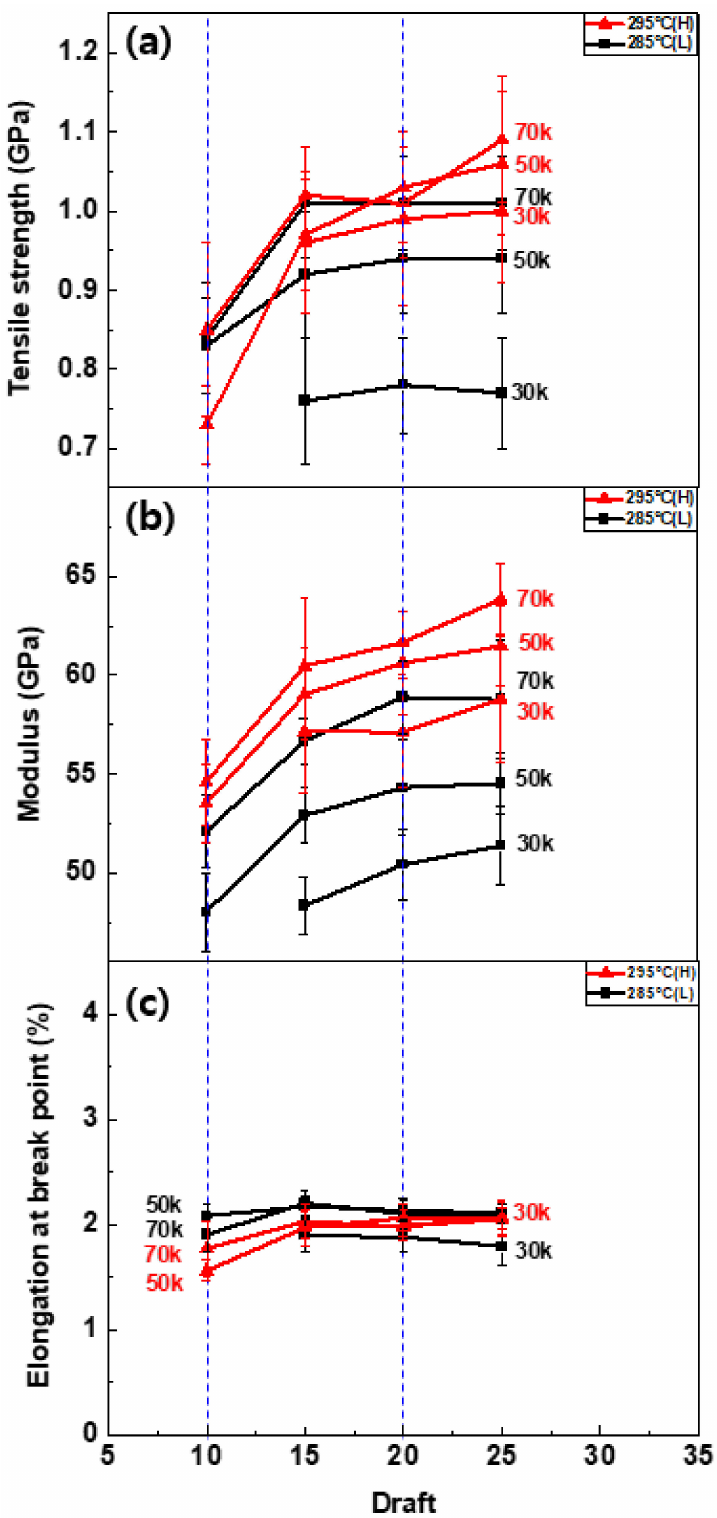
Figure 5. Variations of ( a ) tensile strength, ( b ) modulus and ( c ) elongation at break of as-spun TLCP fibers by the change in the spinning draft. The blue dotted lines indicate the as-spun fibers analyzed by FESEM (Figure 3) and two-dimensional wide-angle X-ray diffraction (2D-WAXD) (Figure 6),